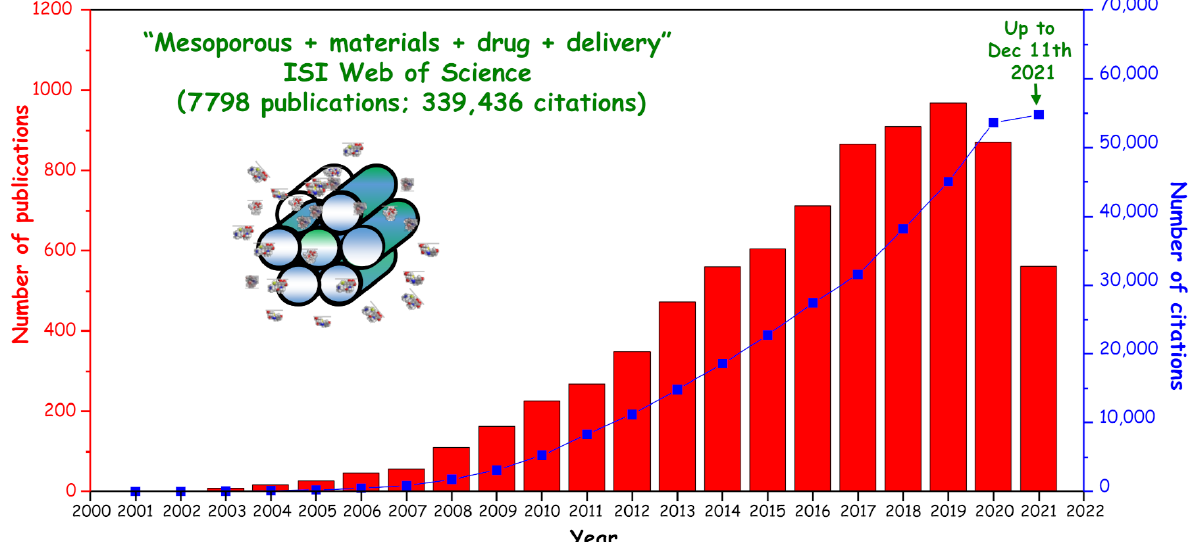
Figure 1. Number of publications per year indexed in the ISI Web of Science on the topic of “meso- porous” and “materials” and “drug” and “delivery” up to 11 December